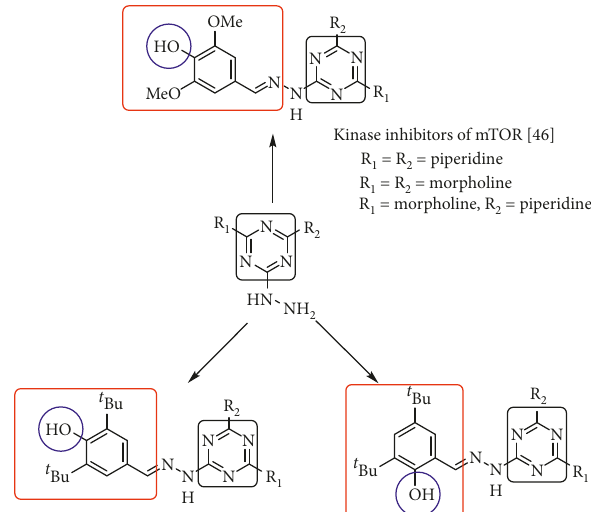
Figure 1: Rational design for the target